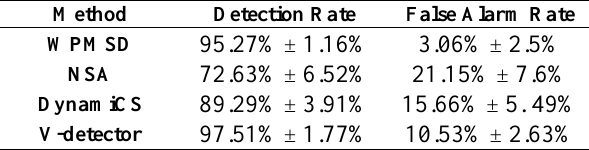
Table 2. The result of comparative experiment